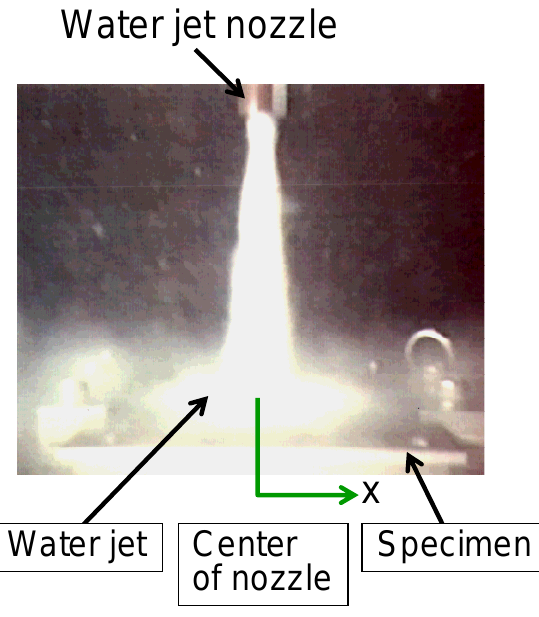
Figure 3. The appearance of water jet peening.